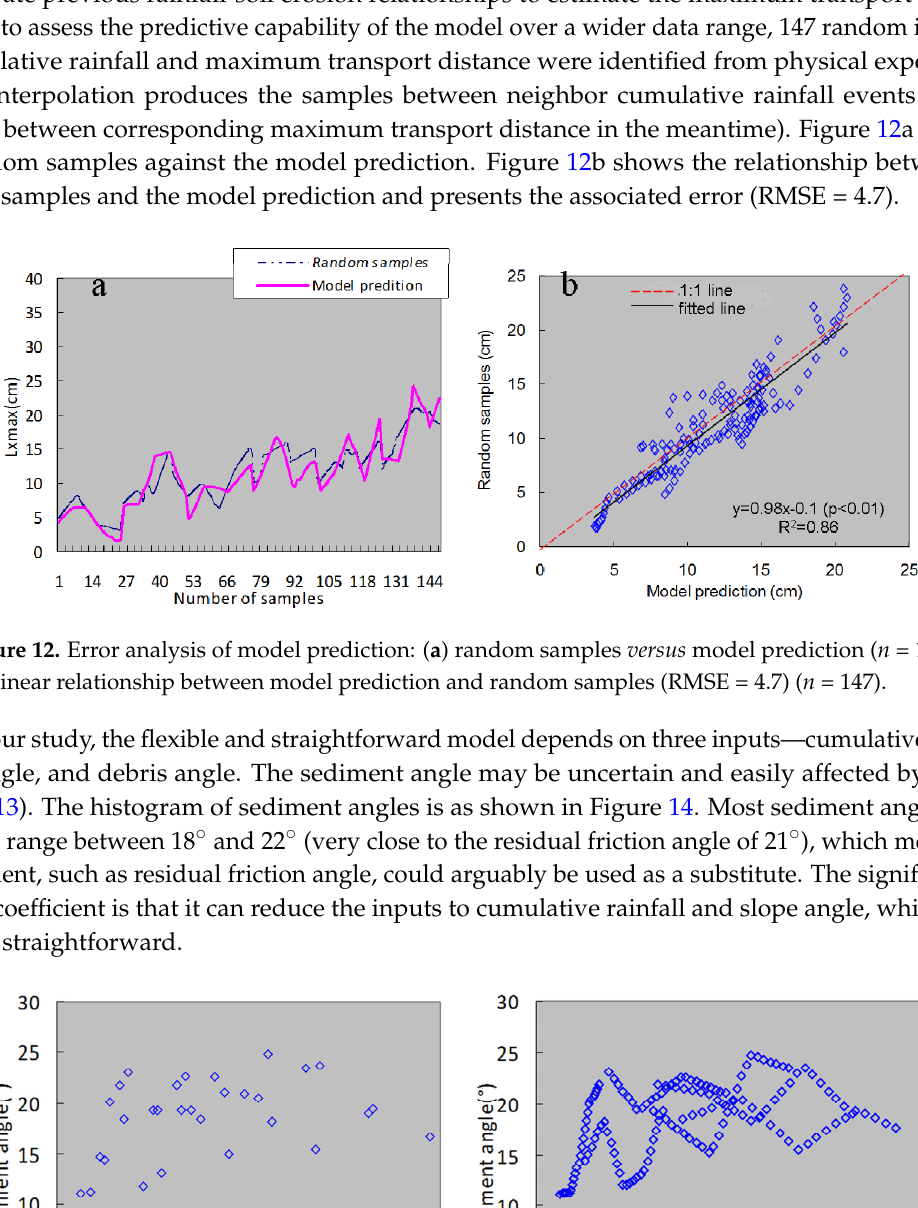
Figure11. The linear model (cumulative rainfall and eroded soil sediment): ( a ) random samples versus model fitting ( n = 147); ( b ) linear relationship between random samples and model fitting (RMSE = 1.2623) ( n = 147).